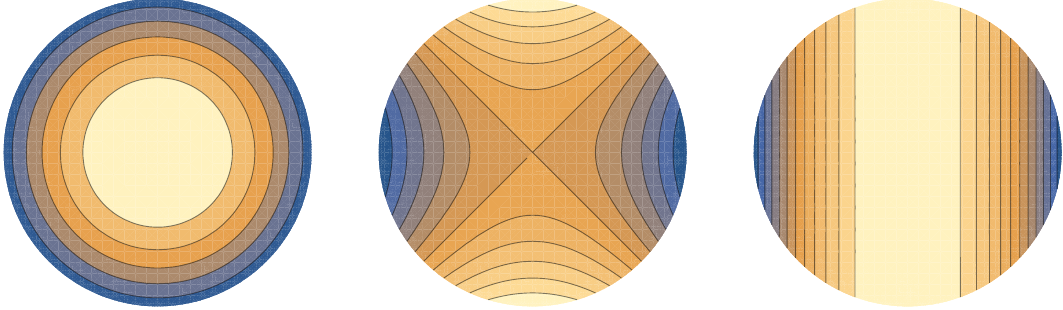
Figure 2 . The (cid:12)rst harmonic eigenfunction ( (cid:12) = 10). On the left and in the middle are the two eigenfunctions, P 0 ( x ) =x and P 2 ( x )cos(2~ (cid:28) ). On the right is the combination of the two eigenfunc- 3 3 tions that represents the transformed Gegenbauer solution from